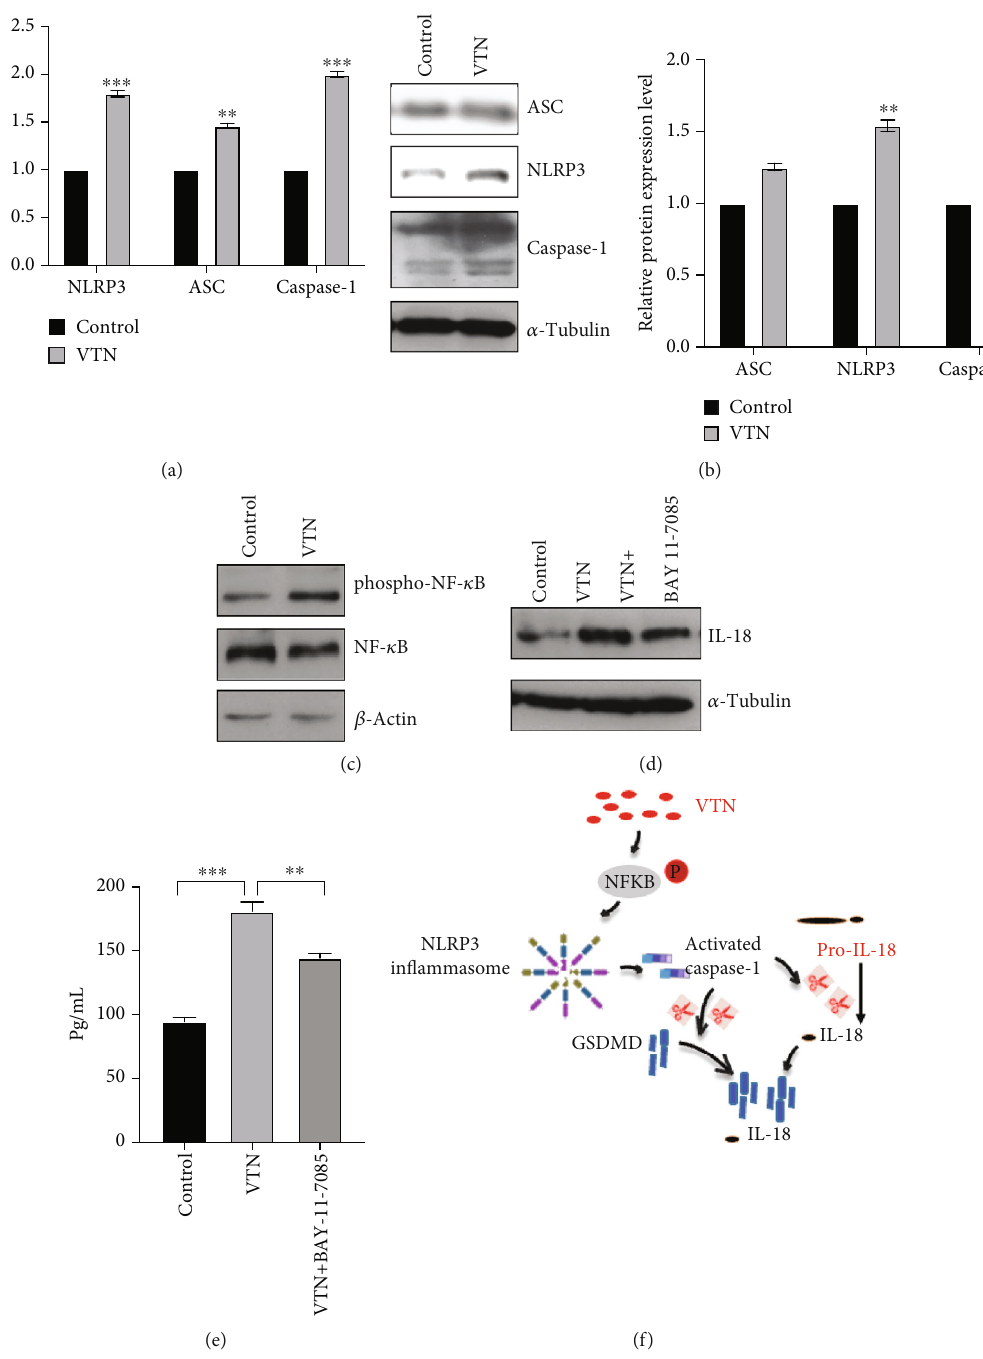
Figure 8: VTN triggered the NF- κ B pathway and NLRP3 in fl ammasome. (a) Real-time PCR and (b) western blotting were performed to detect ASC, NLRP3, and caspase-1 expression in THP-1-derived macrophages with or without VTN treatment. Data represented the mean ± SD of three independent experiments; t -tests were used to analyze statistical signi fi cance; ∗ p < 0 : 05 , ∗∗ p < 0 : 01 , and ∗∗∗ p < 0 : 001 . (c) Phosphorylation of NF- κ B was detected in THP-1-derived macrophages in response to VTN stimulation for 1 hour. (d, e) IL-18 was analyzed by western blotting and ELISA in THP-1-derived macrophages treated with VTN for 1h, followed by BAY 11-7085 stimulation for another 48 hours. Data represented the mean ± SD of three independent experiments; one-ANOVA was used to analyze statistical signi fi cance; ∗∗ p < 0 : 01 , ∗∗∗ p < 0 : 001 . (f) The schematic illustration for VTN-regulated cell